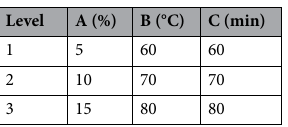
Table 1. The designed levels of the reaction